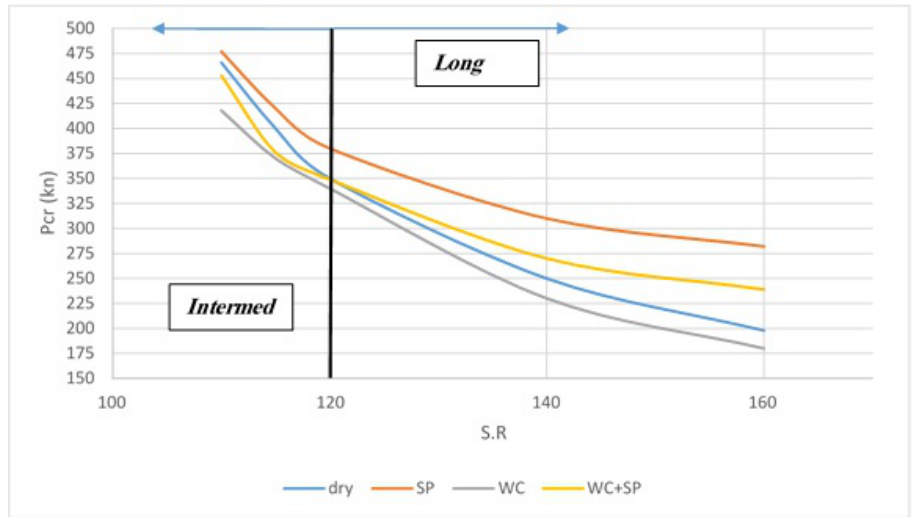
Figure 3: The P cr (dry), (WC), (SP) and (SP+WC) for long and intermediate